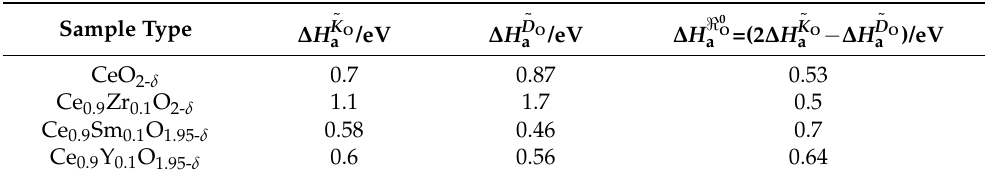
(cid:60) 0 O a = 2 ∆ H (cid:101) K O a − ∆ H (cid:101) D O a